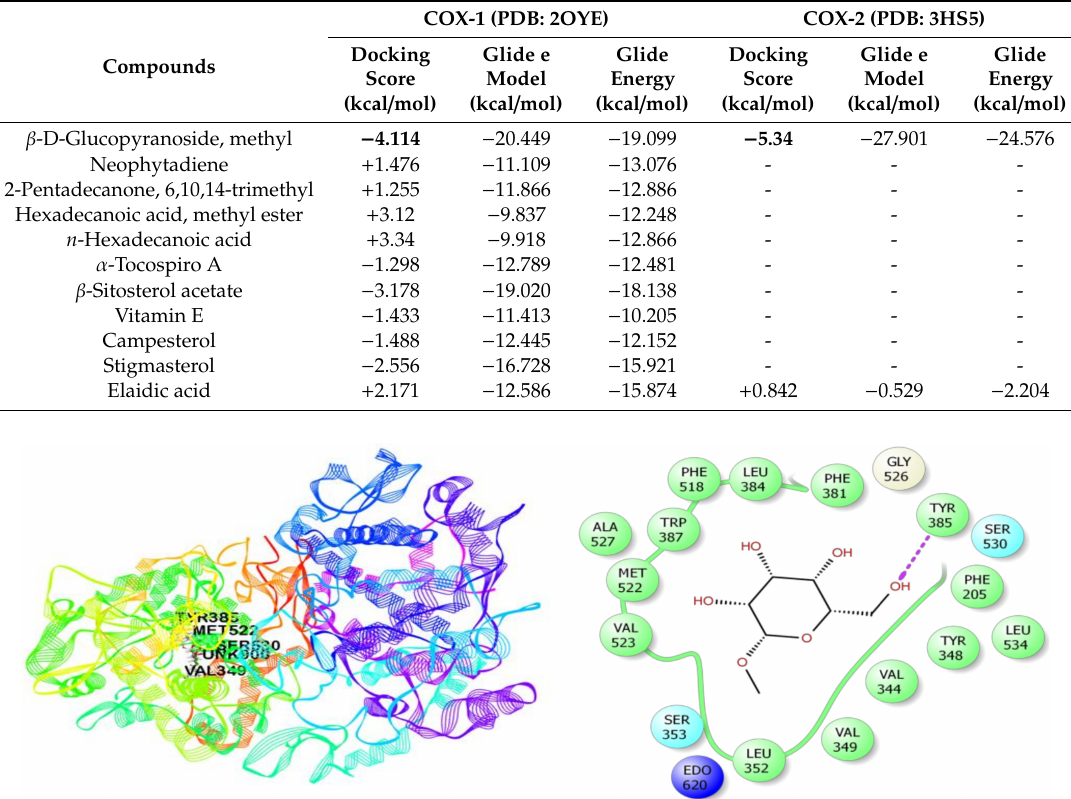
Table 5. DockingscoreoftheidentifiedcompoundswithCOX-1andCOX-2enzymesforanti-inflammatory activity. Bold indicate the highest docking score.